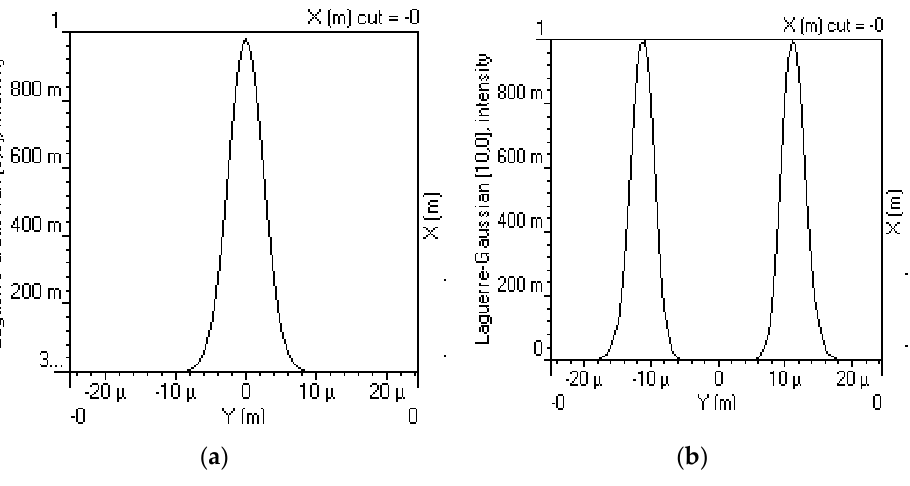
Figure 2. Different LG mode profiles at ( a ) l = 0, m = 0 and ( b ) l = 10, m = 0 in 2D. The number of peaks in the light profile is a function of l and the boundary around these peaks varies with m. These different LG modes with distant values of l are